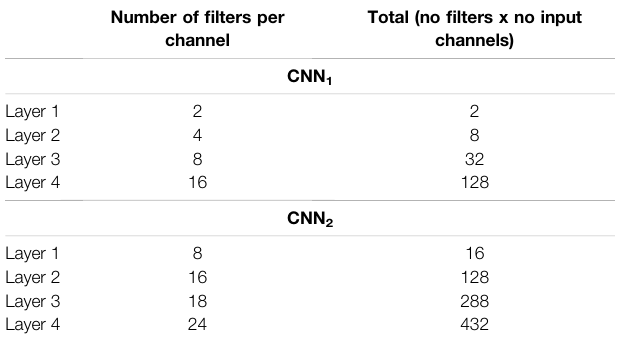
TABLE 3 | Number of fi lters per each convolutional layer for the two CNN models. Number of fi lters per